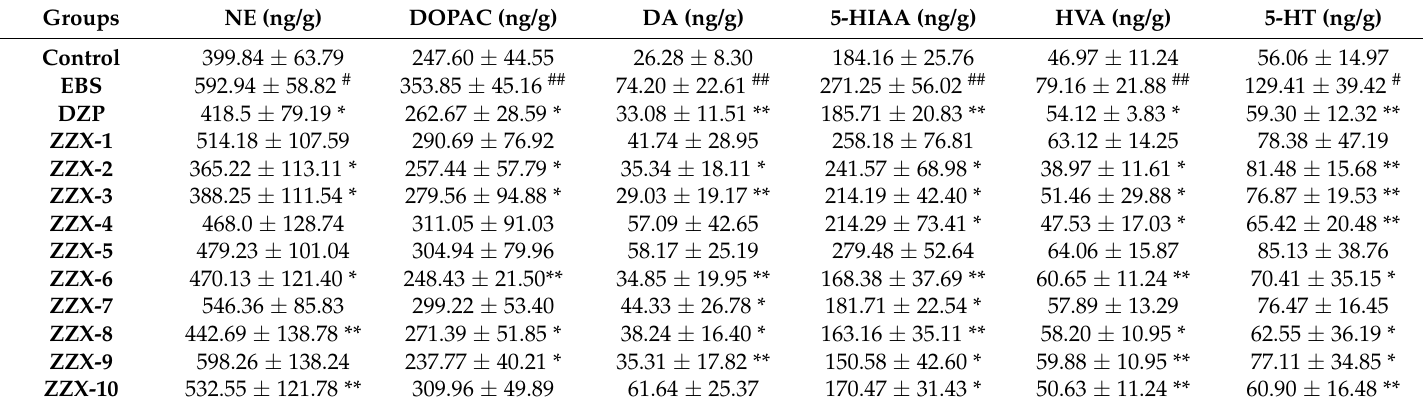
Table 4. Effect of ZZX on the monoamines neurotransmitters and their metabolites in the hippocampus of rats.